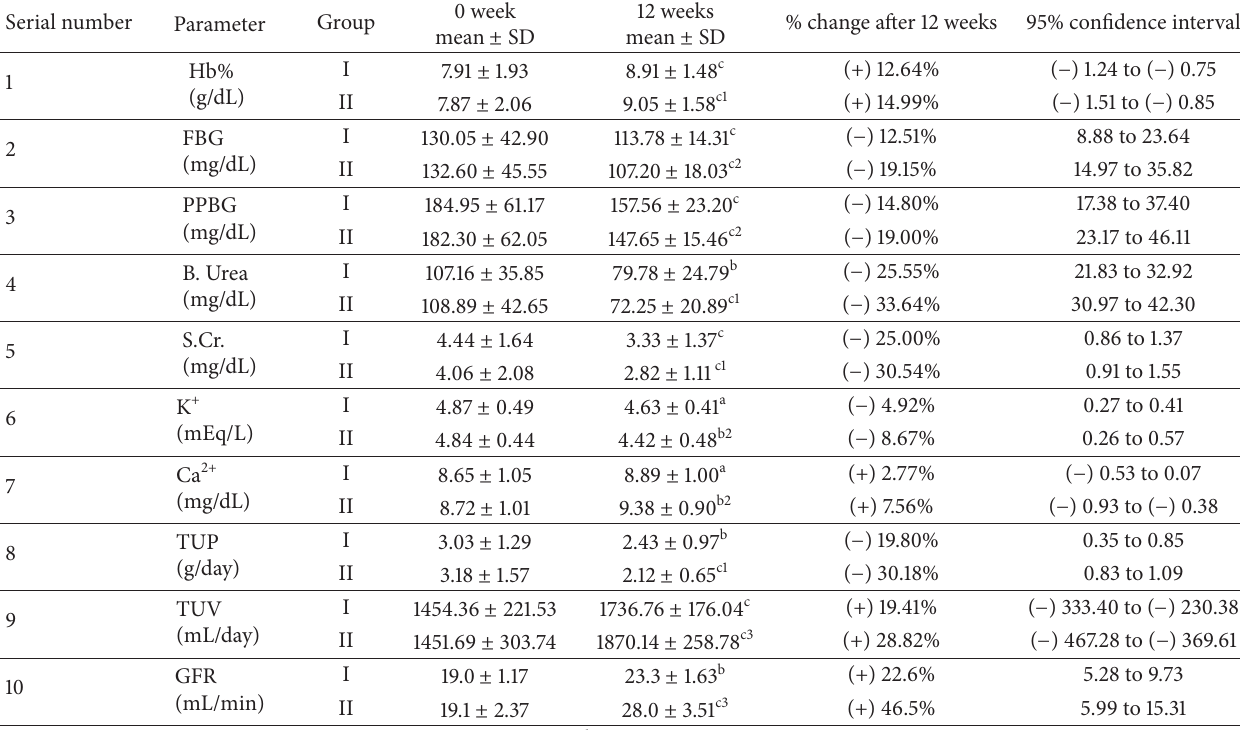
Table 2: Haemogram and renal function tests in control and Rhubarb groups before and after 12 weeks of